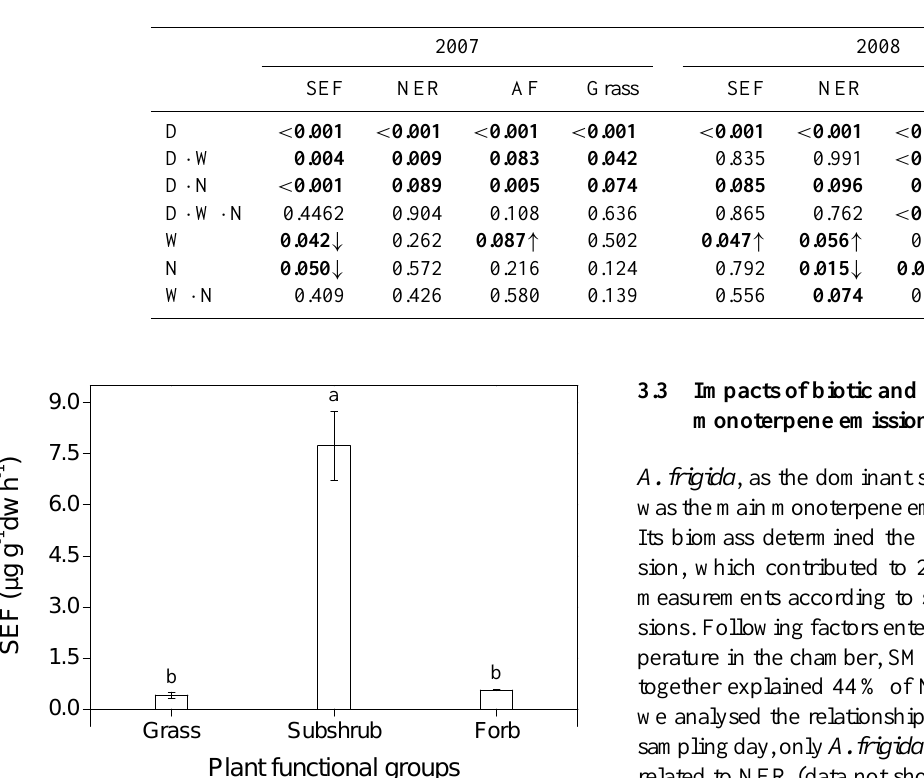
Table 3. Results (p-values) of Repeated Measures ANOVAs on the effects of warming (W), N addition (N), measuring date (D), and their interactions on standard monoterpene emission factor (SEF), natural monoterpene emission rate (NER), A. frigida biomass (AF) and grass biomass in 2007 and 2008. Arrow direction shows the significantly and marginally positive ( ↑ ) or negative ( ↓ ) effects, which are highlighted in bold type.